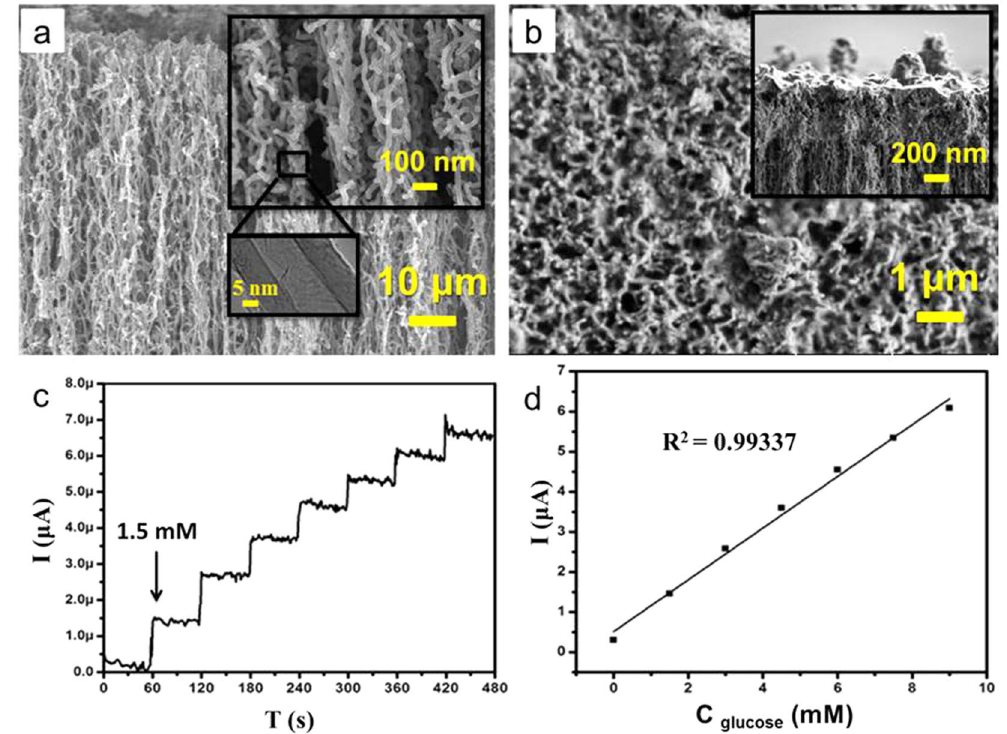
Figure 1. Structural property and chronoamperometric analysis of the enzymatic glucose biosensor. ( a ) FESEM image of synthesised MWCNTs, and ( b ) top view of the composited vertically aligned MWCNTs with Gl and GOx before sonication (inset is the cross section of the composited vertically aligned MWCNTs with Gl and GOx befor sonication). ( c ) Chronoamperometric response of GOx/MWCNTs/Gl/GCE on the successive addition of 1.5 mM glucose in each successive addition at applied potential of + 0.3 V. ( d ) Calibration curve of the electrocatalytic current on different concentrations of